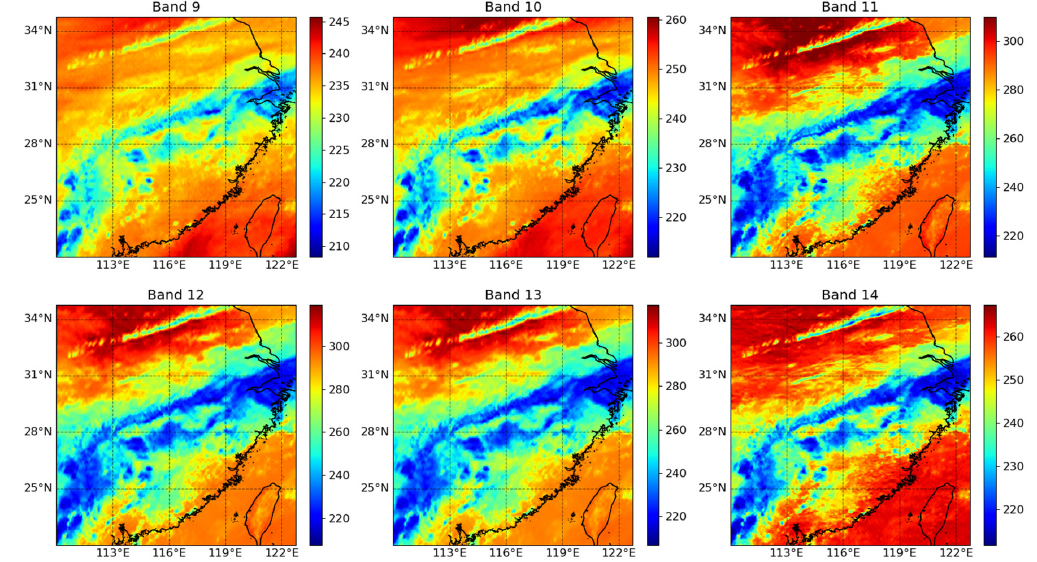
Figure 1. The infrared band observation images of the FY-4A satellite (Example time 3 June 2020).